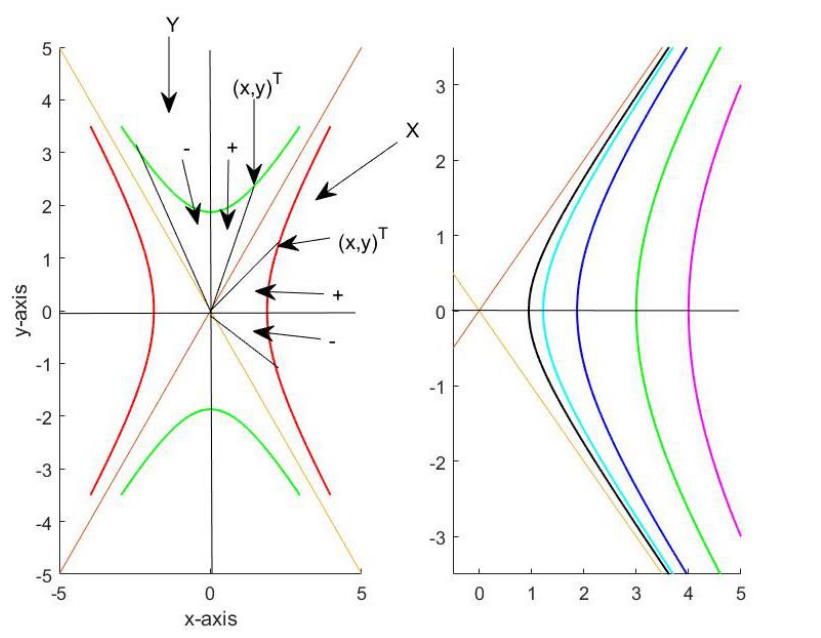
Figure 2. Signed area contents ( left ) and disjoint cone decomposition ( right ).